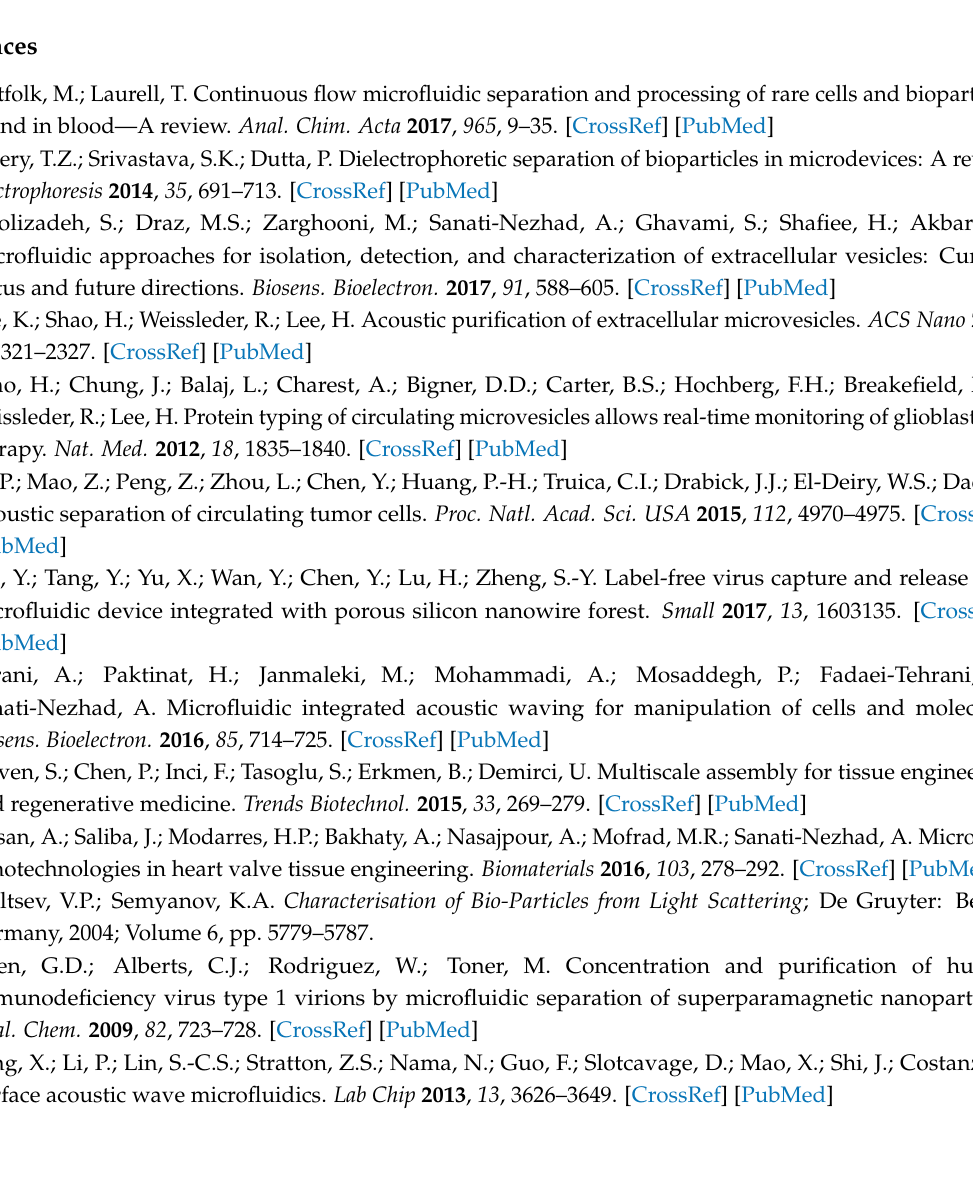
Figure S1: Comparison between ideal, viscous and thermoviscous fluid in calculation of the acoustic radiation force (ARF) applied on the small bioparticle (BP) suspended in an acoustic standing field. (A) Acoustic contrast factor of the BP in water as a function of δ v /a. Ideal theory suggests a steady contrast factor while viscous and thermoviscous theories predict a variable contrast factor. However, the difference between these values are negligable; (B) The ARF error when using an ideal fluid compared to viscous (green dashed line) or thermoviscous (blue solid line) fluid. Results demonstrate that the maximum ARF error with an ideal fluid assumption is less that 1%, however the error significantly decreases with increasing the acoustic frequency. The detailed properties are presented in Table 1; Table S1: Comparison of the ARF values obtained from different studies along with the results of ASI model in present study; Table S2: Properties of the cell/particle and fluid (water) for calculation of ARF results shown in Table